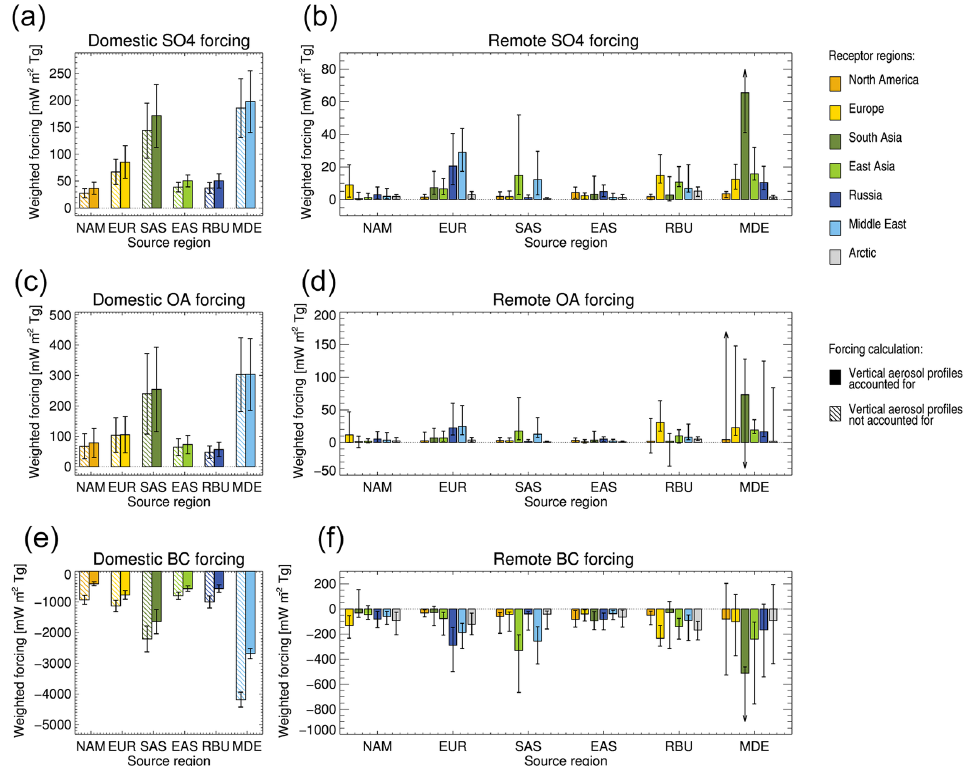
Figure 9. Regionally averaged forcing in the six source regions due to domestic emission reductions (leftmost column) and remote forcings averaged over different receptor regions due to emission reductions in the six source regions (rightmost column) for the three aerosol species (tow row: SO 4 ; middle row: OA; lower row: BC). Forcings are weighed by the emission change in each given source region. The source region in question is marked on the x axis, while the receptor region for which the forcing is averaged is marked by the color of the bar. See Tables S6 through S8 for the numbers behind this